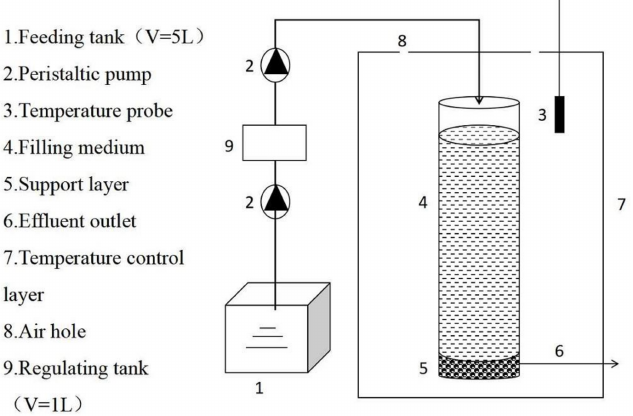
Figure 3. Experimental CRI system. CRI: constructed rapid